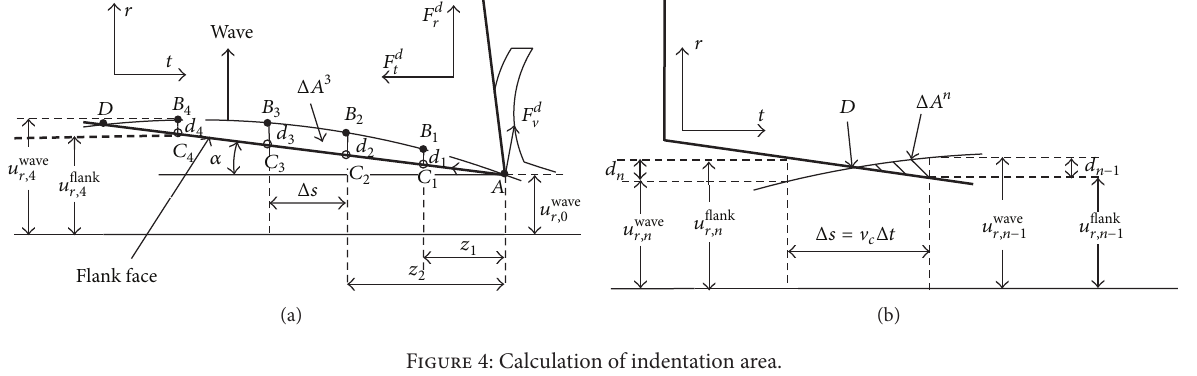
Figure 4: Calculation of indentation area.